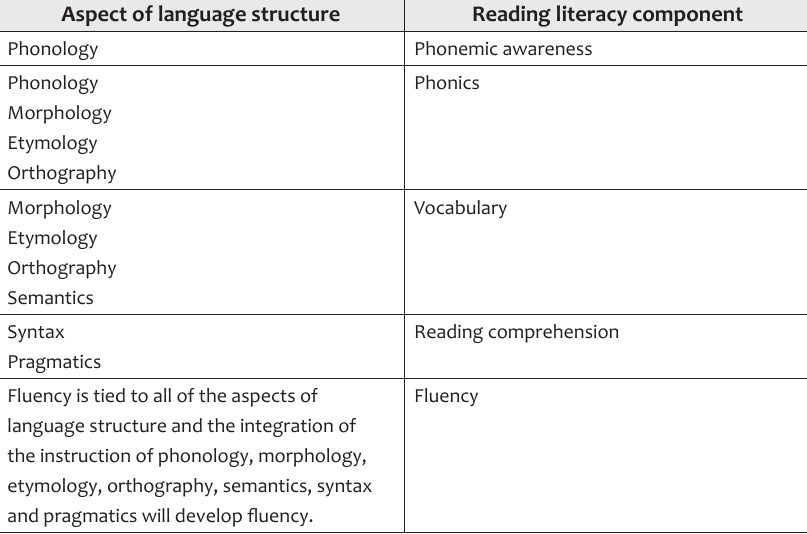
Table 2.1: The disciplinary knowledge base required to teach the reading literacy components Aspect of language